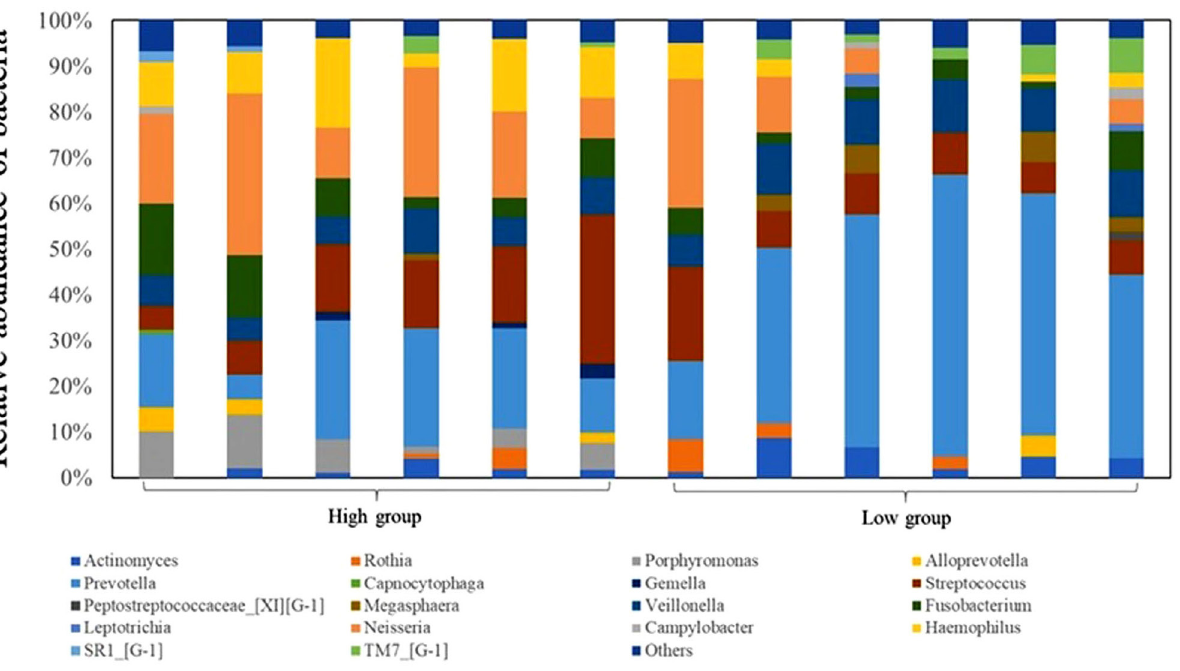
Figure 2- Column plots of genera and relative abundance of bacteria in tongue coating. Bacterial flora with relative abundance <1% were classified as